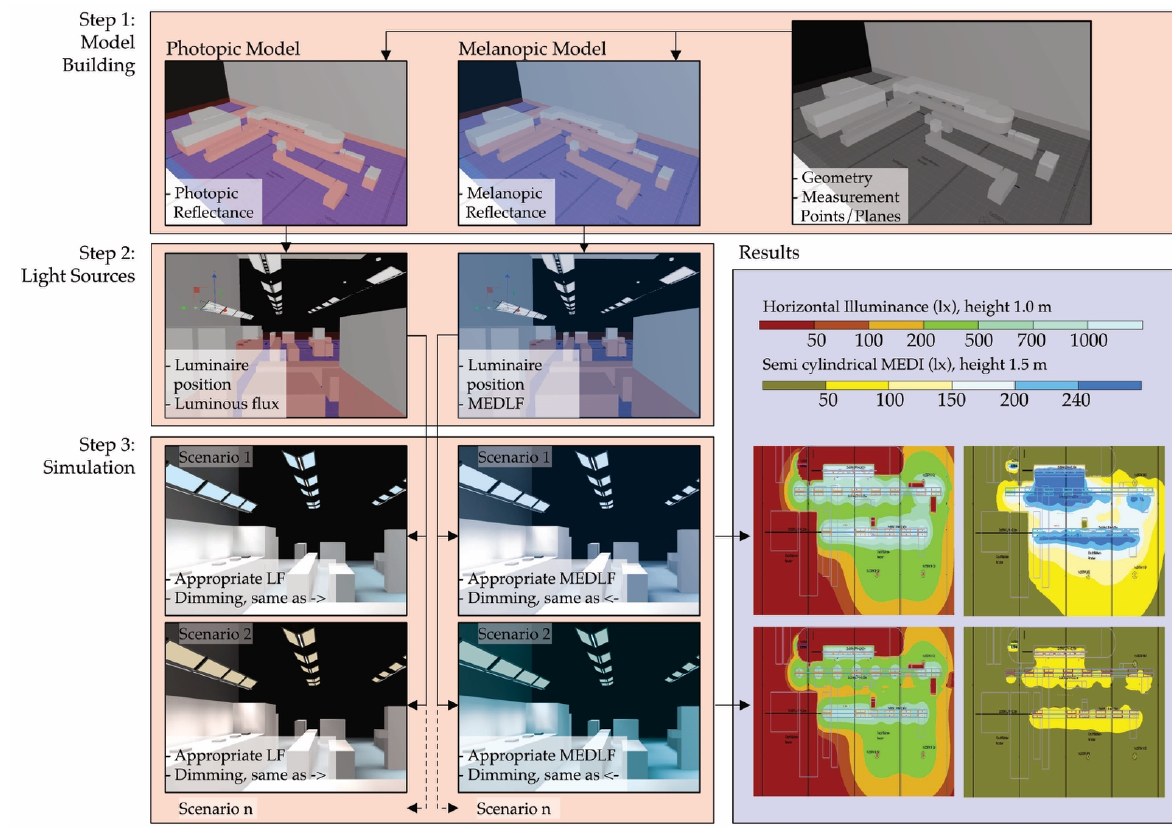
Figure A1. Schematic of the nonvisual lighting simulation process with standard lighting design tools. The schematic is complementary to the text in Appendix A. LF is the luminous flux, and MEDLF is the melanopic equivalent of daylight (D65) luminous flux. The result interpretation benefits from different false-color scales depending on the model.